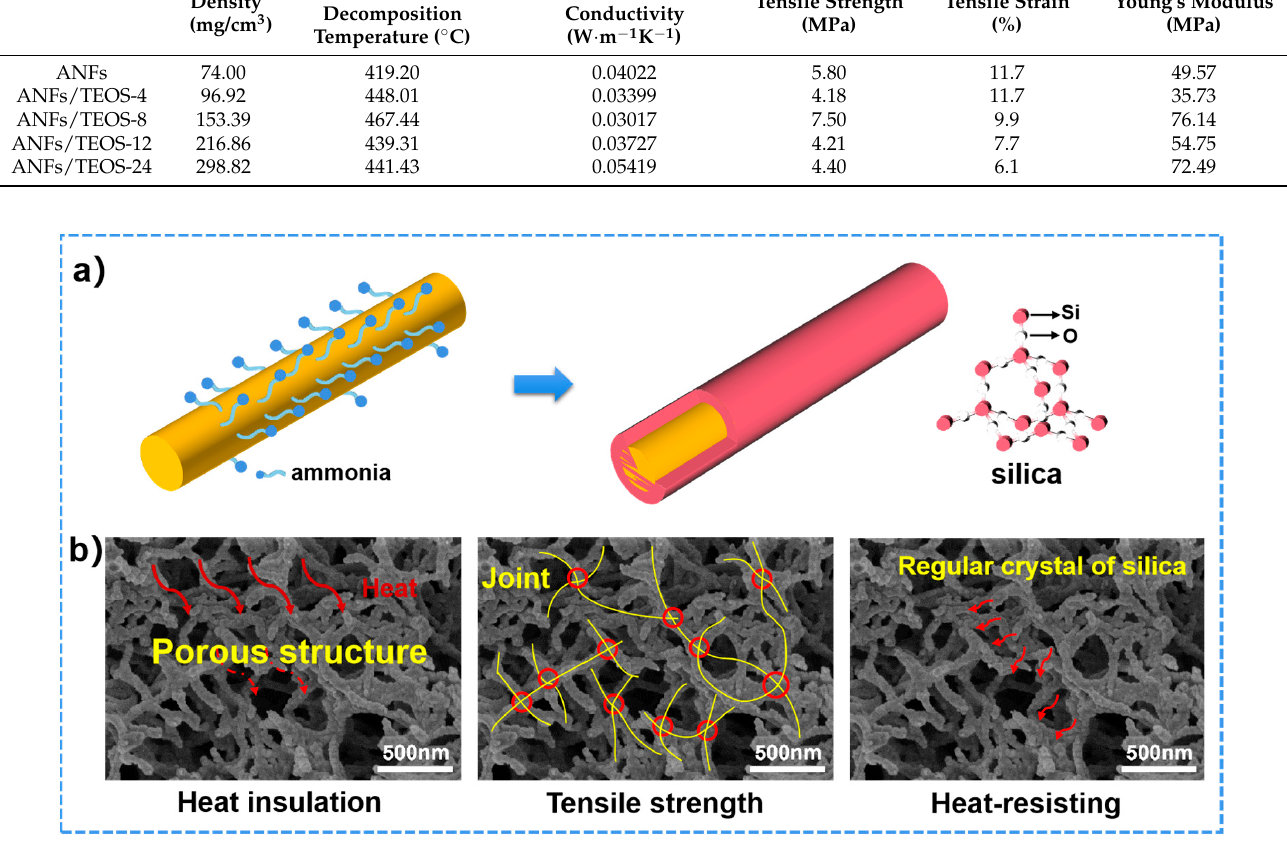
Figure 8. ( a ) Changes of small molecules on the surface of aramid fiber and shell-core structure of ANFs/TEOS during gas phase polymerization. ( b ) Structural schematic of the advantages of ANFs/TEOS-8. Table 1. Density, initial decomposition temperature, thermal conductivity, tensile strength, and Young’s modulus of ANFs and ANFs/TEOS aerogels.